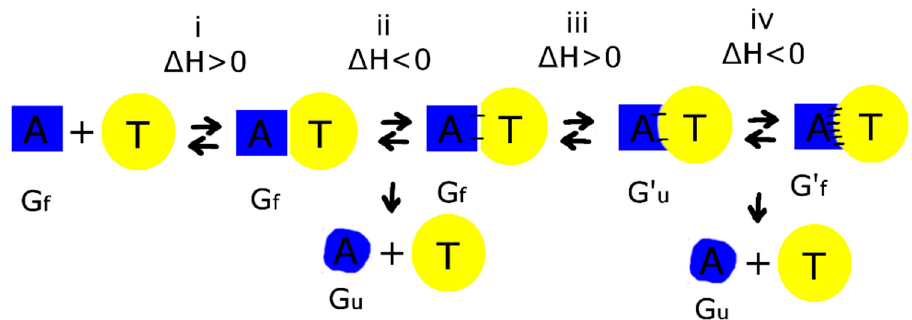
Figure 7. Schematic representation of the stages of complex formation between aptamer (A) and thrombin (T). Black dashes are hydrogen bonds. G and G ′ are two different conformations of the G-quadruplex module, ‘f’ and ‘u’ refer to folded and unfolded states, respectively. Enthalpy favorable stages yield ‘side product’—an unfolded G-quadruplex module that dissociates from the intermediate complex.